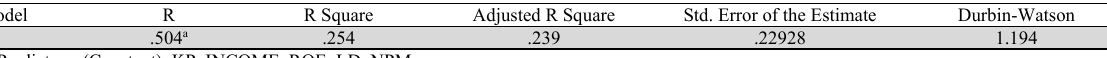
Autocorrelation Test